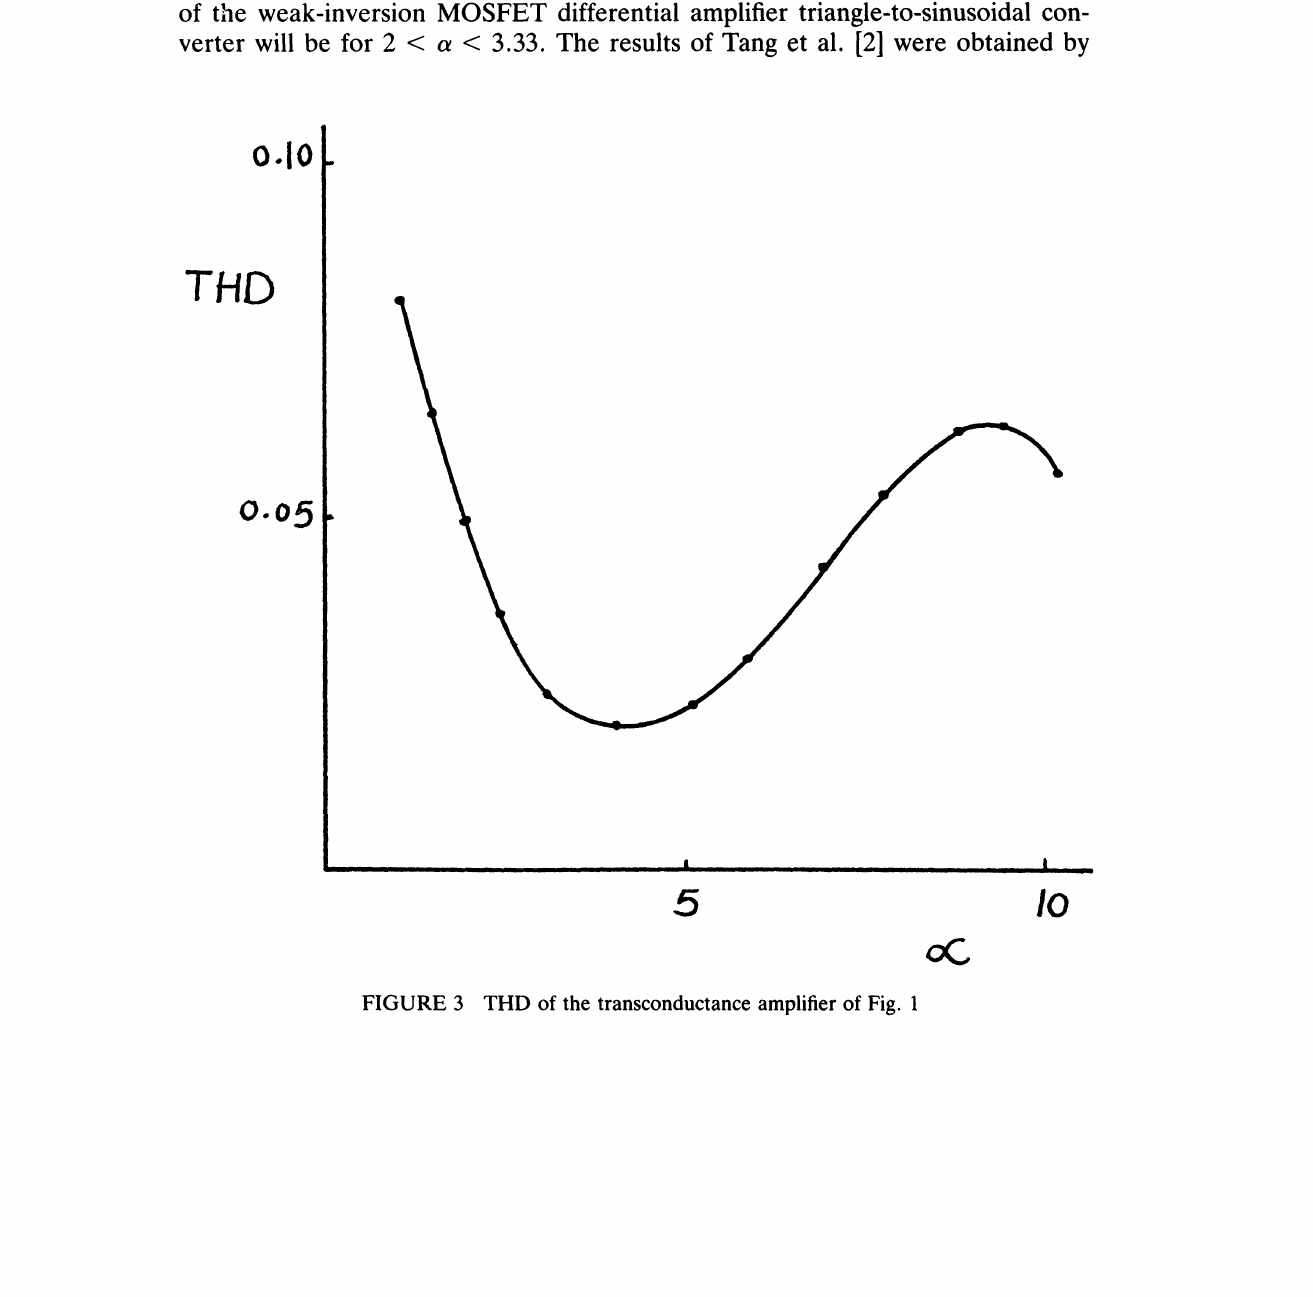
FIGURE 3 THD of the transconductance amplifier of